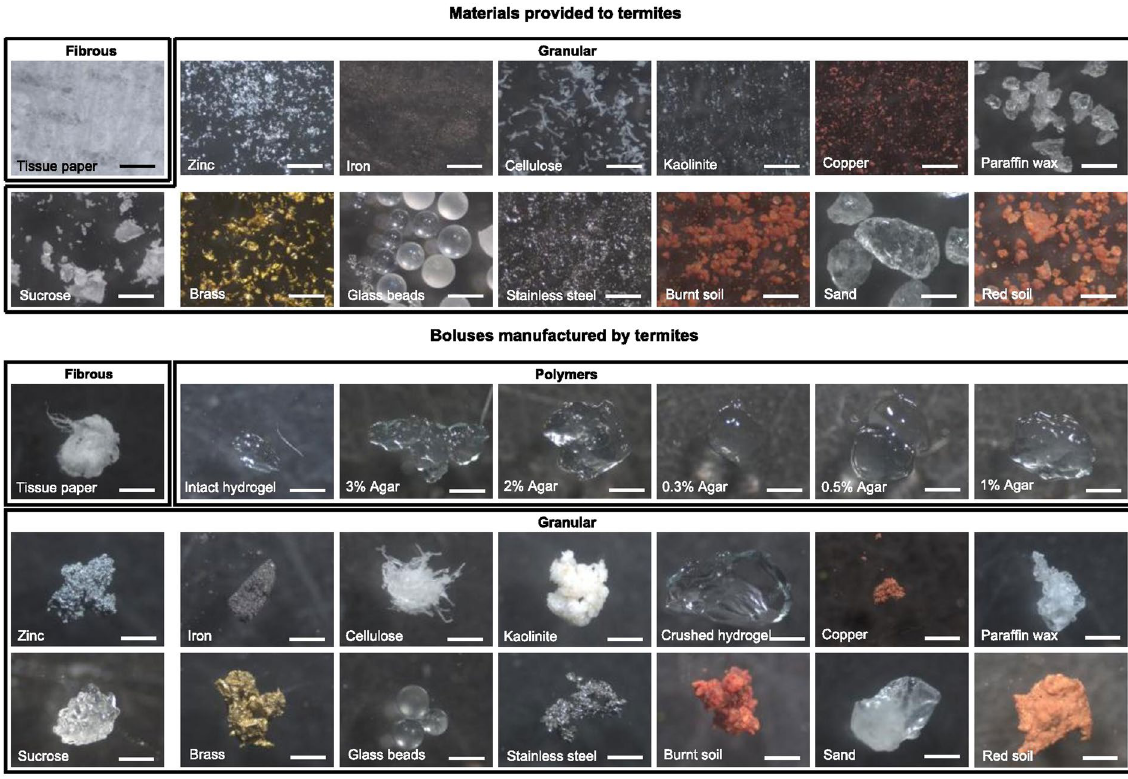
Figure 1. Boluses made by major workers with different materials (material indicated on each image). No boluses were made with 0.1%, 0.2% agar and sodium chloride. Scale bars represent 0.5 mm.